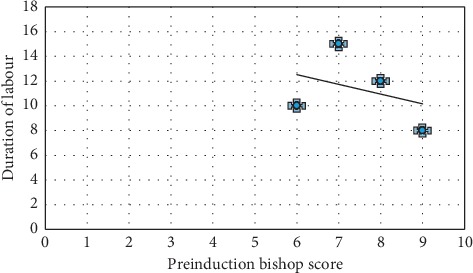
Association between induction delivery interval and clinically measured Bishop score.